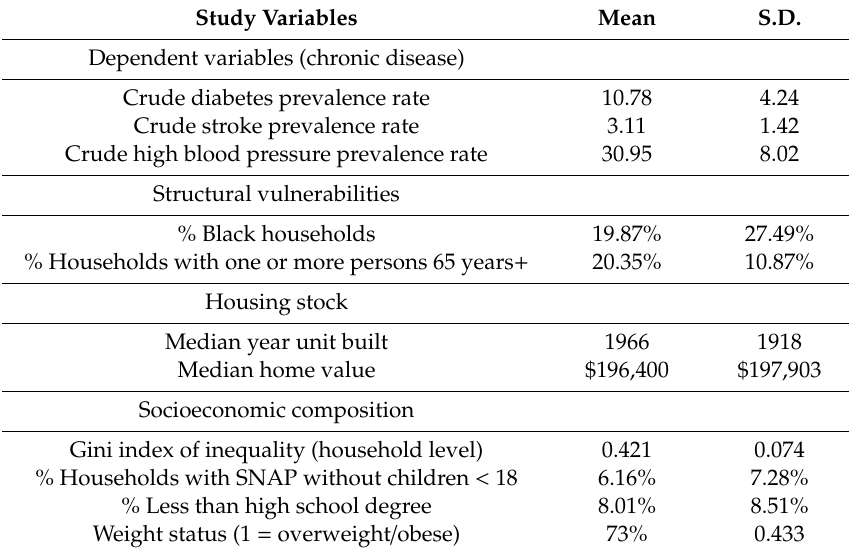
Table 1. Descriptive statistics for study variables in the 500 largest U.S. cities,